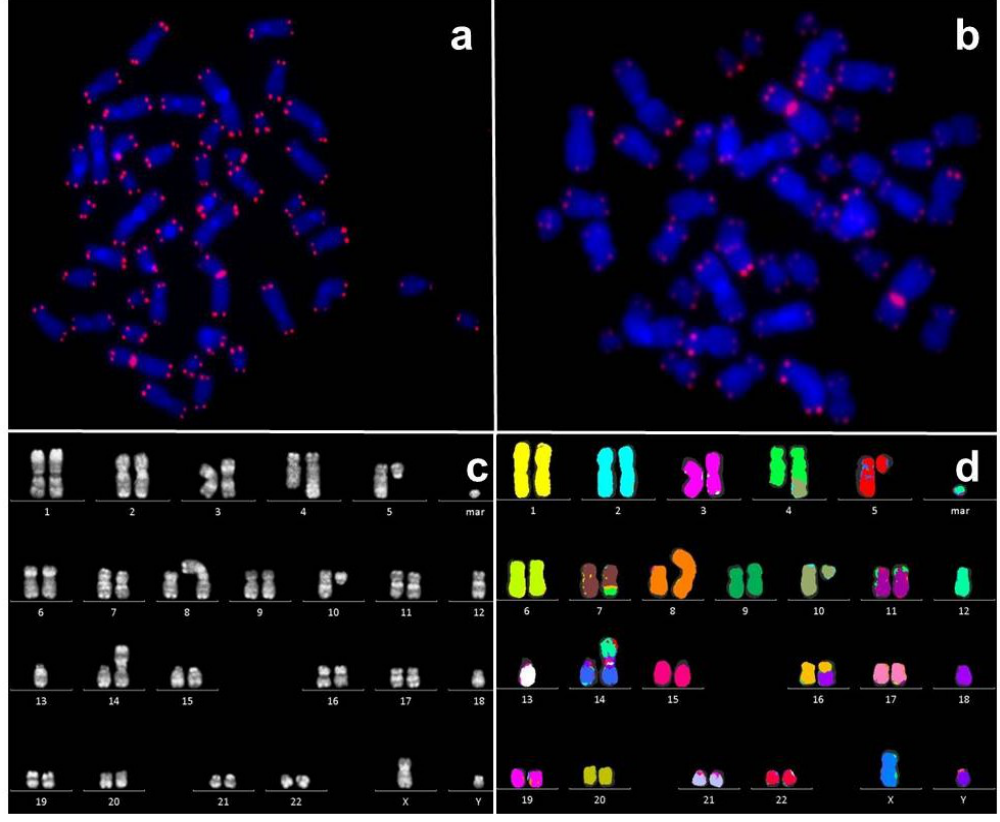
Figure 1. Imaging methods for chromosomal instability and shortened telomeres ( a ) Telomere/Centromere (T/C)-FISH metaphase of a healthy individual; ( b ) T/C-FISH metaphase of a patient with MDS and shortened telomeres; ( c ) Fluorescence R-banding karyotype of a patient with AML and complex aberrant karyotype, ( d ) Multicolor FISH karyotype of the same